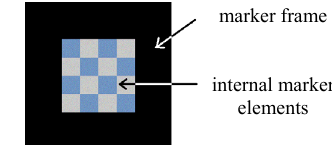
Fig. 1. Marker frame with outlined internal elements inside it.